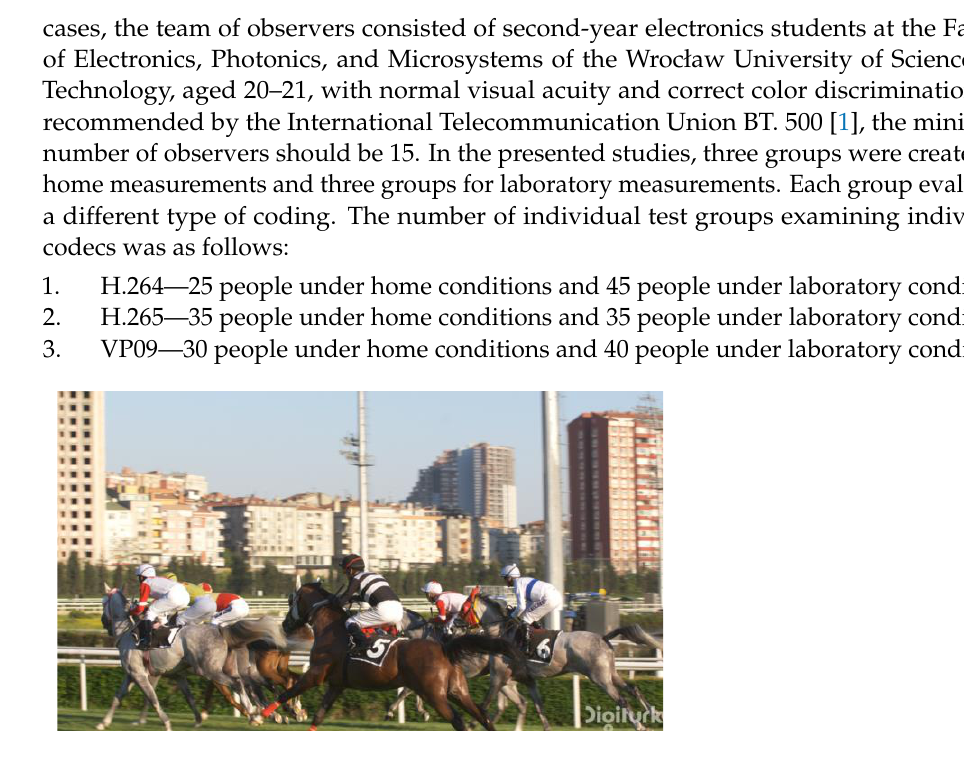
Figure 1. An example frame from the original video.